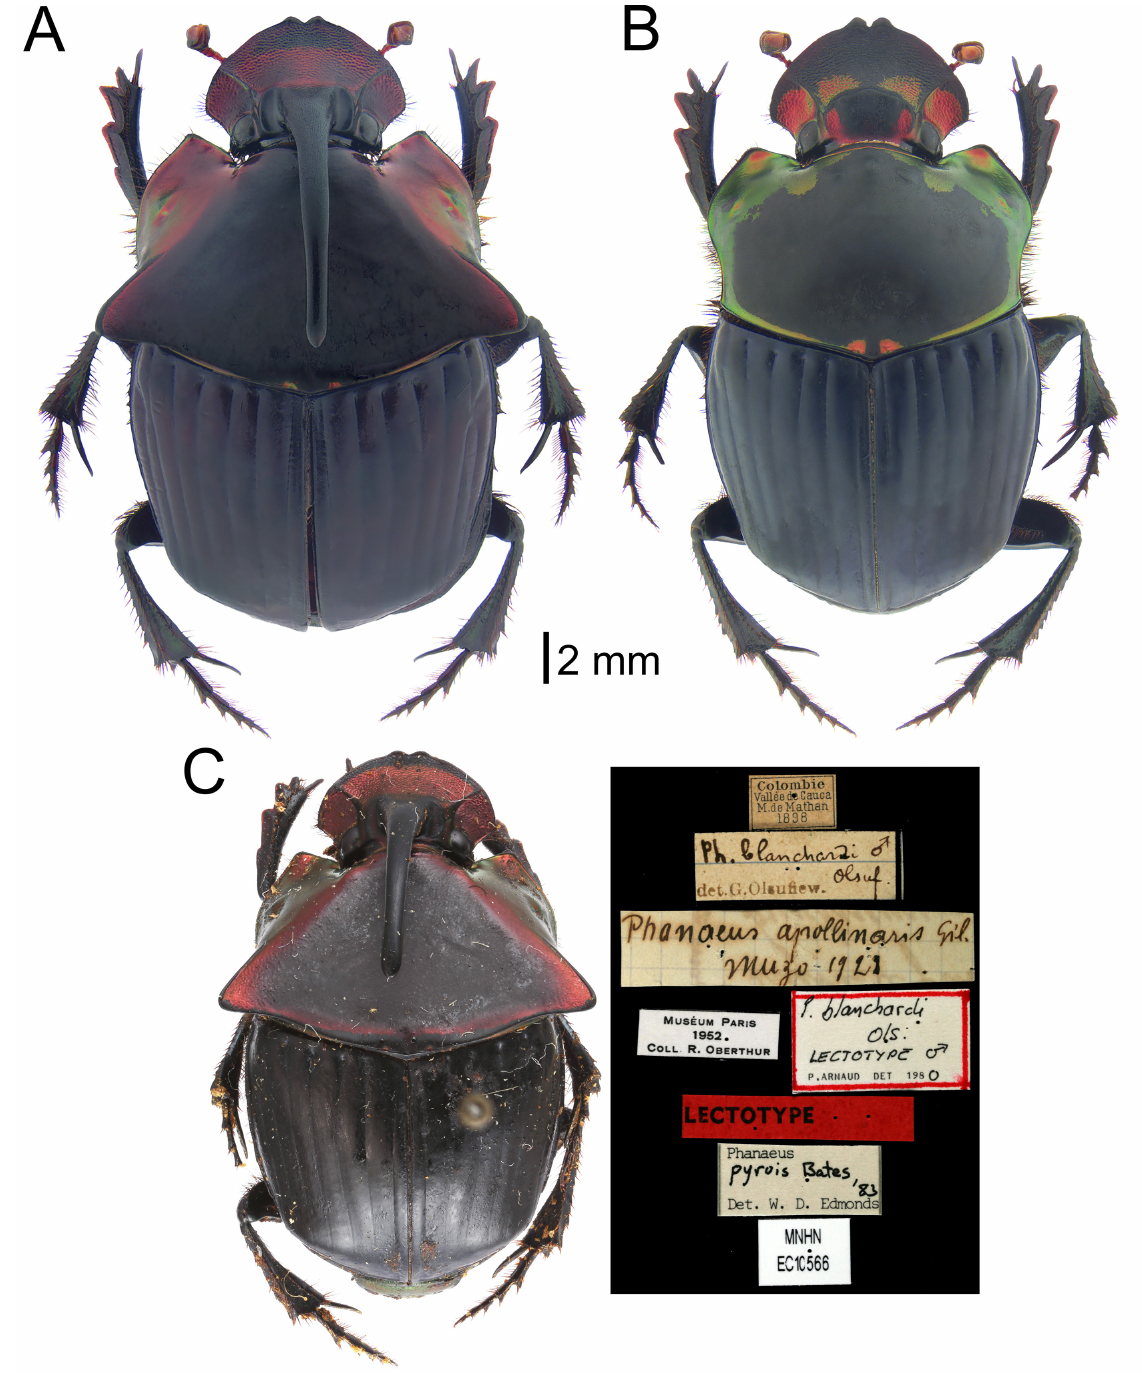
Fig. 8. Phanaeus olsoufieffi Balthasar, 1939 stat. rev. A . ♂ (TAMU). B . ♀ (TAMU). C . Lectotype ♂ (by Christophe Rivier, Muséum national d’histoire naturelle, Paris, France)